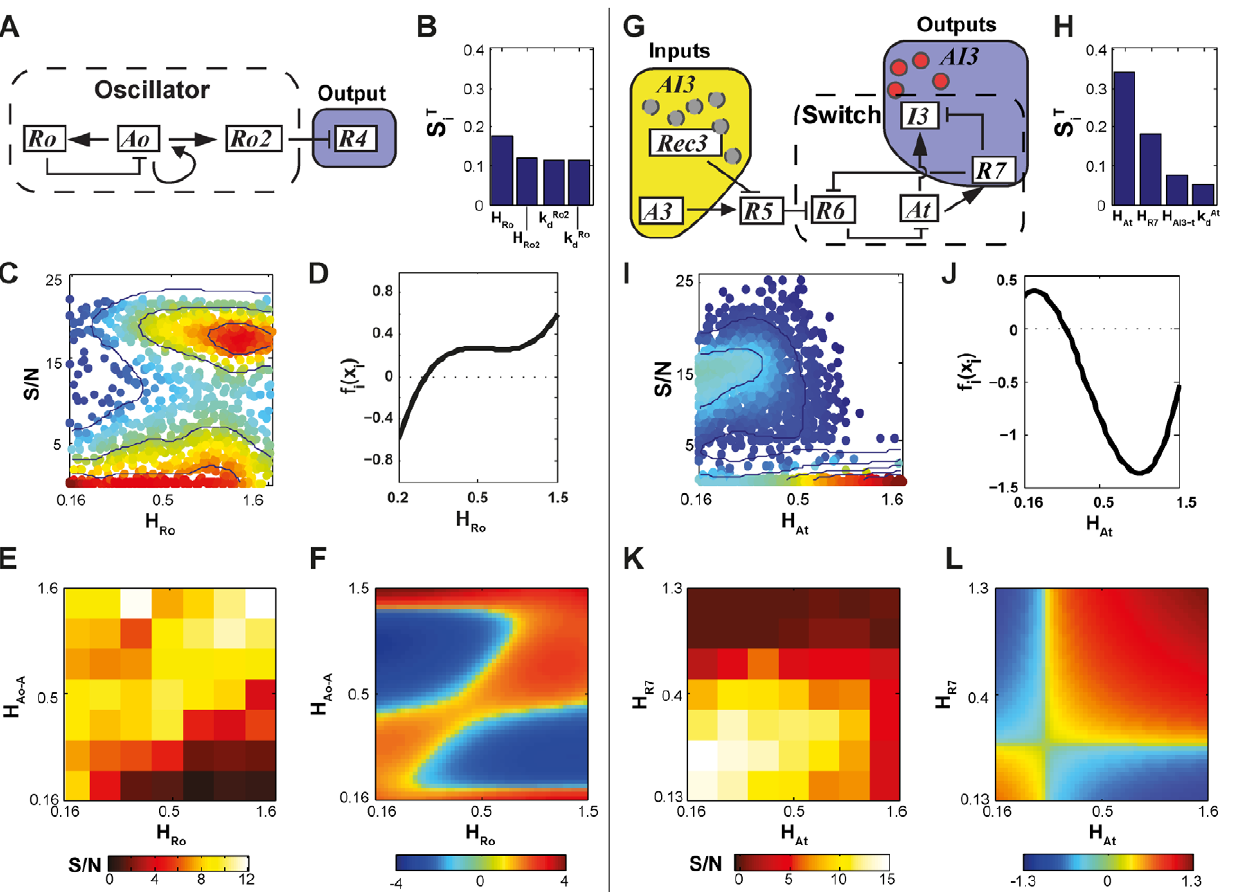
Figure 7. Parametric sensitivity analysis. (A,G) Circuit diagrams of the genetic components considered in (A) oscillator and (G) throttle , for parametric variations of the oscillator and throttle, respectively. (C,I) optimization. (B,H) The most significant RS-HDMR sensitivity indices, S T i Observed S/N values as a function of randomly sampled rate constant values. Around 2000 different parameter sets were tested, with all oscillator or throttle parameters simultaneously varied. Each point represents an individual parameter set. Warmer colors and contour lines indicate higher point density. (D,J) Inferred first-order RS-HDMR functions describing S/N as a function of the parameters sampled in C and I . (E,K) Heat map of the S/N values against the parameters resulting from the 2000 parameter sets tested in C and I . (F,L) RS-HDMR second-order functions describing the cooperative effects between rate constants, corresponding to E and K . Second-order RS-HDMR functions capture remaining variance after the first- order functions (see D and J ) have been subtracted from the